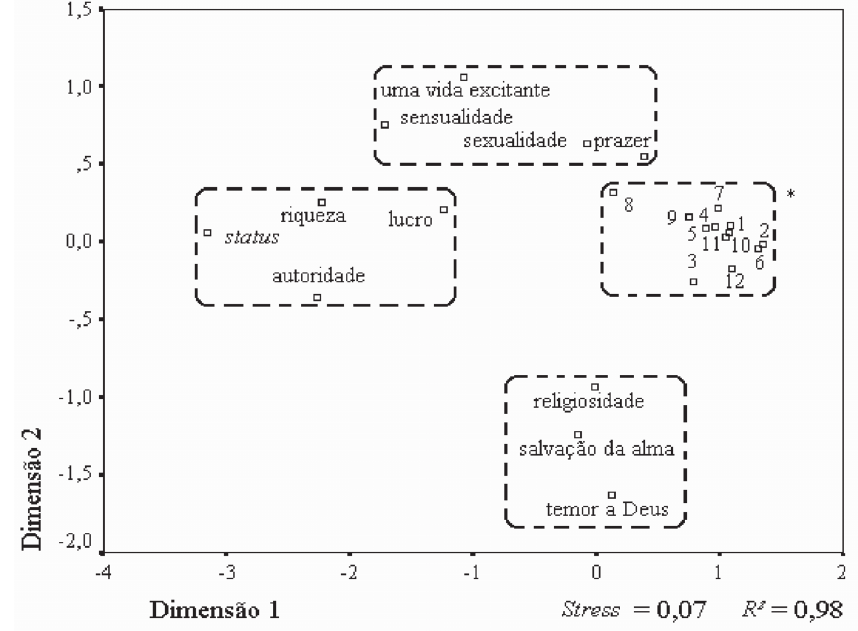
Figura 2 . Representação gráfica dos resultados da multidimensional scaling aplicada aos valores. Nota. * Os valores contidos neste quadro são os seguintes: 1=igualdade; 2=justiça; 3=liberdade; 4=fraternidade; 5=alegria; 6=auto-realização; 7=amor; 8=conforto; 9=competência; 10=dedicação ao trabalho; 11=realização profissional; 12=